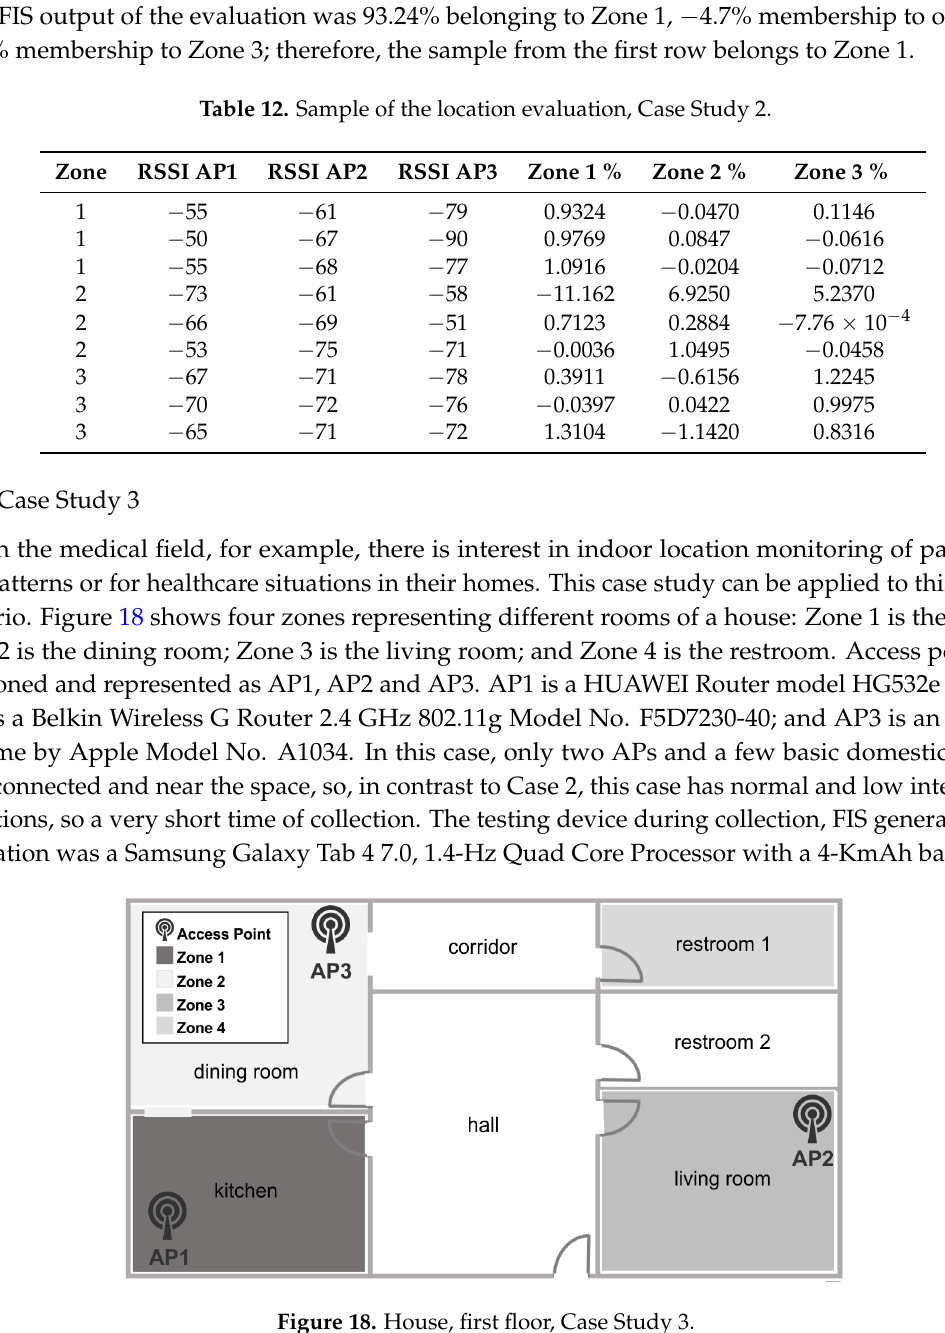
Figure 18. House, first floor, Case Study